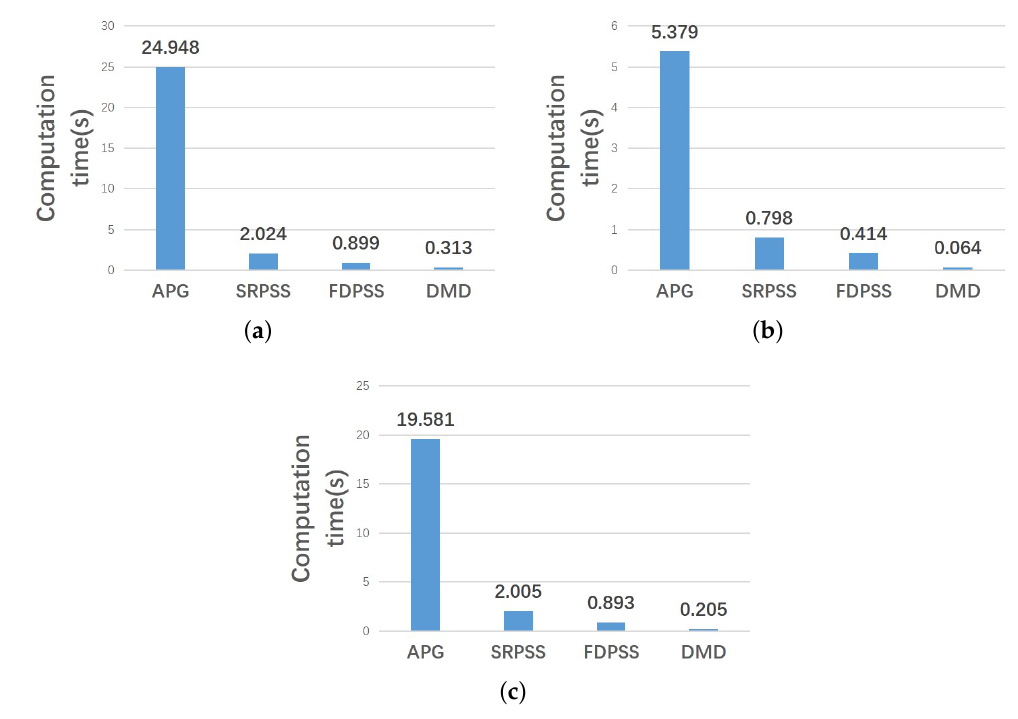
Figure 5. Results of calculation. ( a ) is the result of the first set of data; ( b ) is the result of the second set of data; ( c ) is the result of the third set of